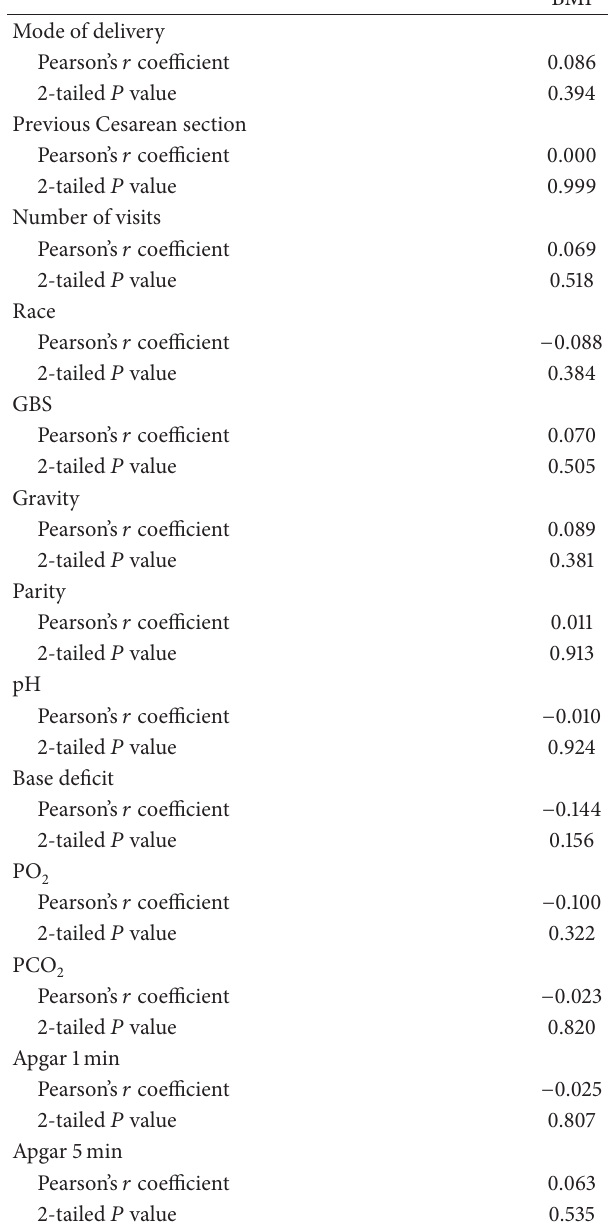
Table 2: Correlation of BMI with different